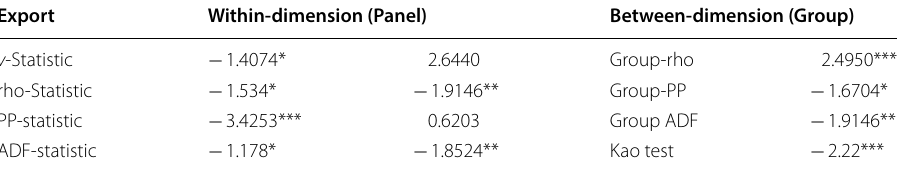
Table 5 Pedroni and Kao cointegration test (export is dependent variable)